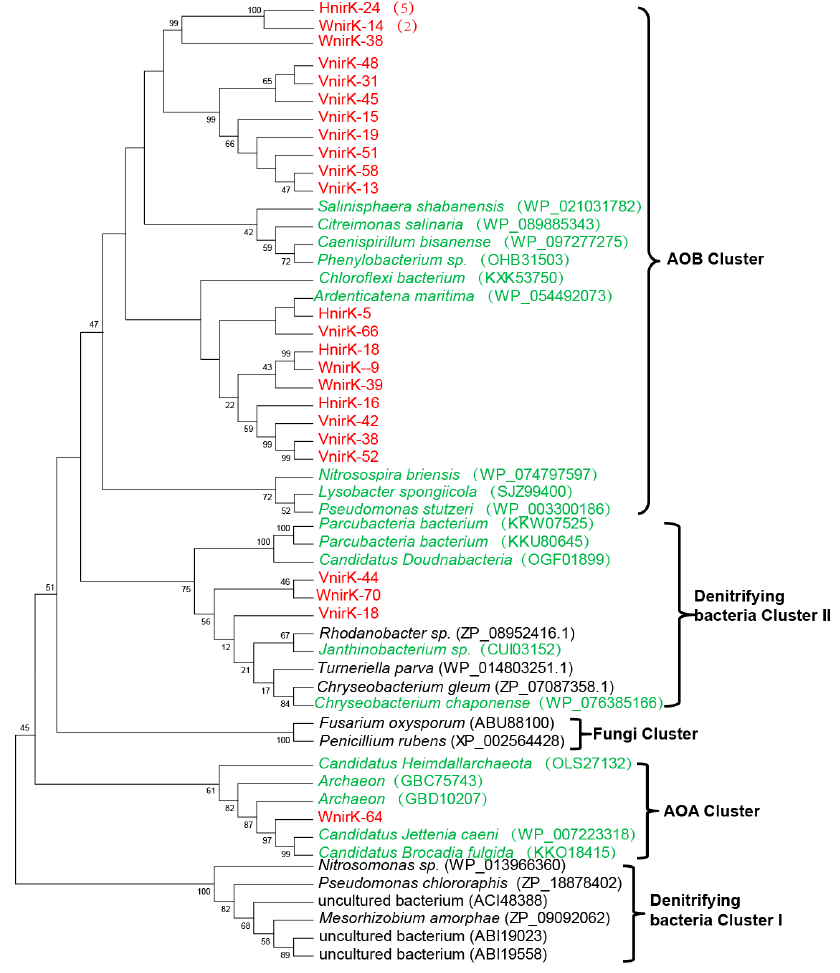
Figure 4. Phylogenetic analysis of NirK gene products (partial, 140 amino acids) from sample QL ‐ H (HnirK), sample QL ‐ V (VnirK), and sample SR ‐ W (WnirK) bacteria (in red). The 19 candidate NirK